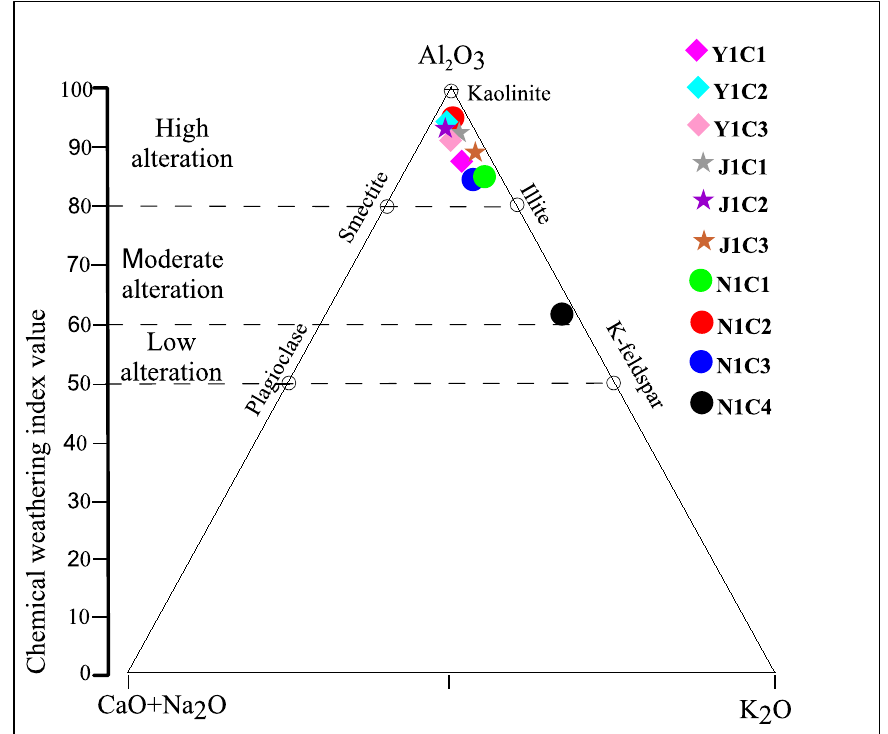
Figure 8. Position of the studied clayey materials in the ternary diagram of Nesbitt and Young